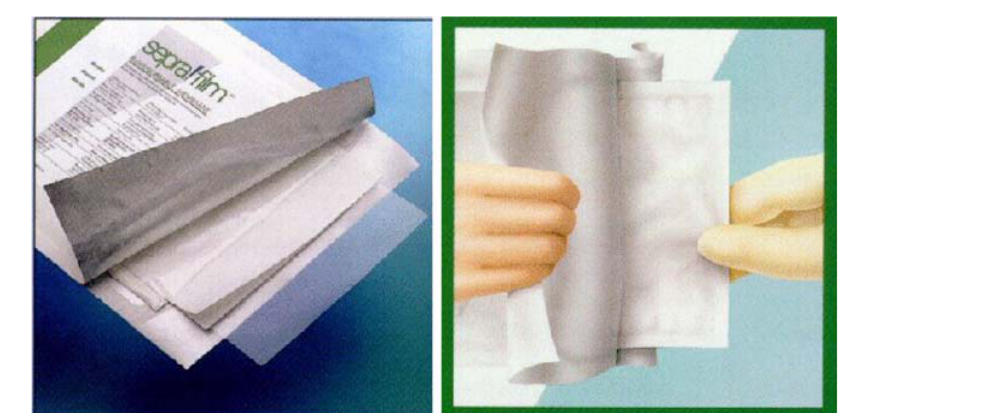
FIGURE 1 - Each biologically absorbable Seprafilm ® membrane is individually wrapped and sterilized, and must be handled using dry sterilized gloves. Available from